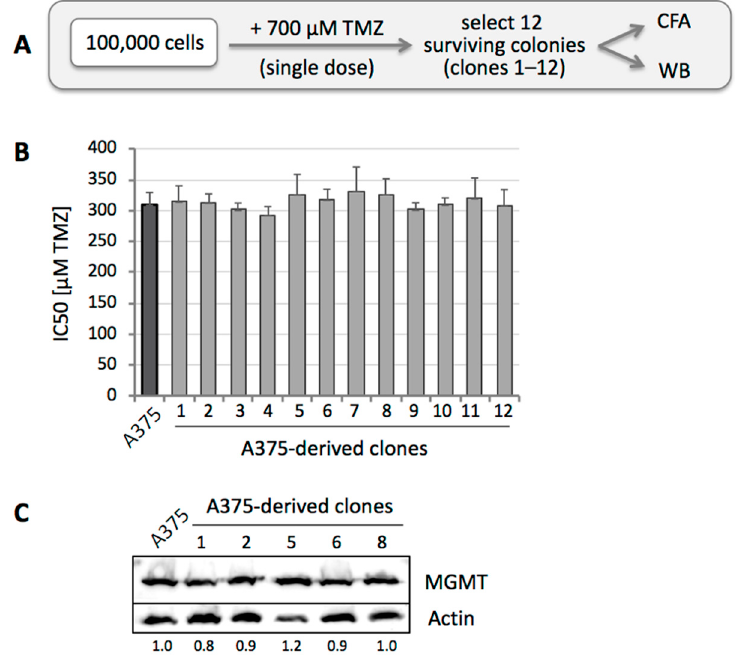
Figure 2. Selection of A375 clones after high-dose TMZ treatment. ( A ) Treatment schedule was as follows: 10 5 A375 cells (MGMT positive) were seeded into a 10-cm dish and treated with a single dose of 700 µ M TMZ for 48 h. Two weeks later, 12 surviving clones (numbered 1 through 12) were isolated for further analysis by WB and CFA. ( B ) All twelve clones were subjected to CFA with increasing concentrations of TMZ. Shown is the average IC50 of each clone, in comparison to parental A375 cells (left bar in black) ( n = 2–5, ± SE). ( C ) Five of these cell clones were lysed, and MGMT protein levels were analyzed by WB with actin as the loading control. Left lane shows lysate from parental A375 cells. Numbers under the blot indicate quantification of MGMT bands, with reference to the actin signal, and relative to A375 cells (left lane, set at 1.0).